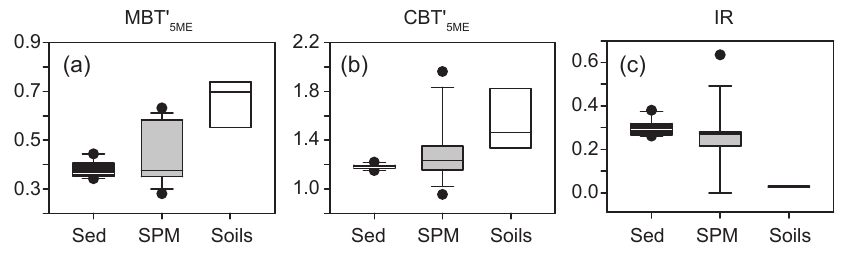
Figure 6. BrGDGT-based proxies measured on surface sediments (black), SPM (gray), and catchment soils (white). (a) Methylation of branched tetraethers (MBT (cid:48) ). (b) Cyclization of branched tetraethers (CBT (cid:48) 5ME